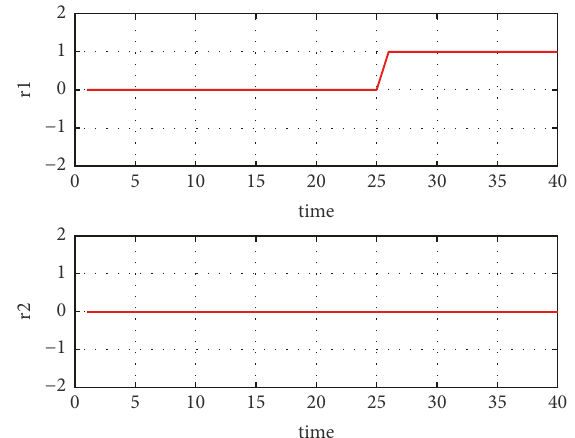
Figure 8: Normalized residue for stepand decreaseof theamplitude